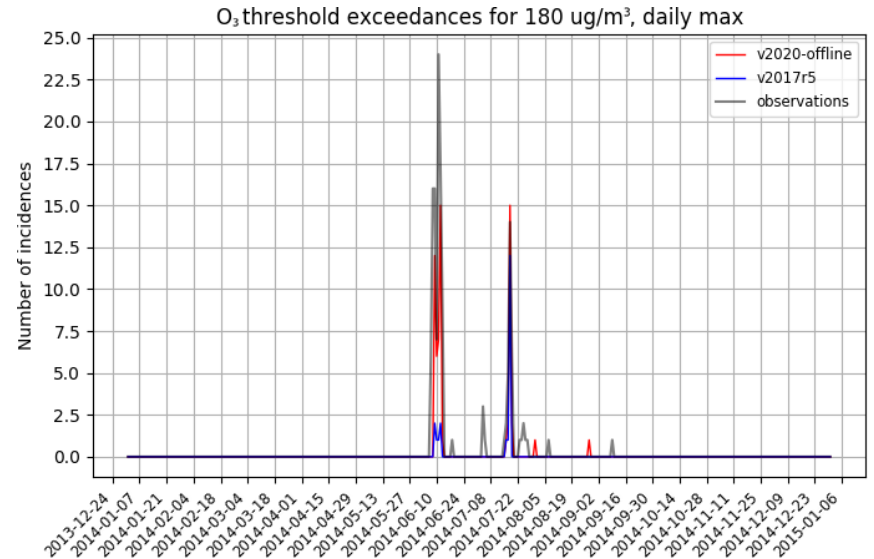
Figure 4. Time series of surface ozone daily exceedances, measured with the EMEP network and modeled with CHIMERE v2017r5 and v2020r1.